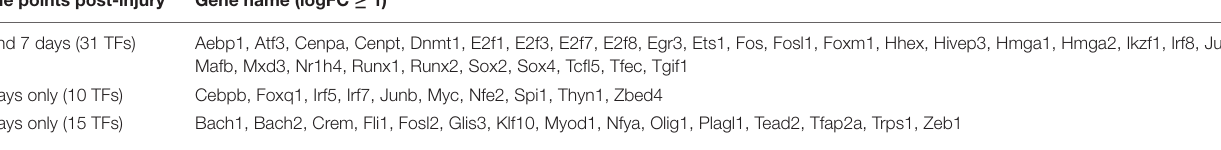
TABLE 1 | TFs with at least twofold upregulation post-injury in the mouse distal sciatic nerve. Time points post-injury